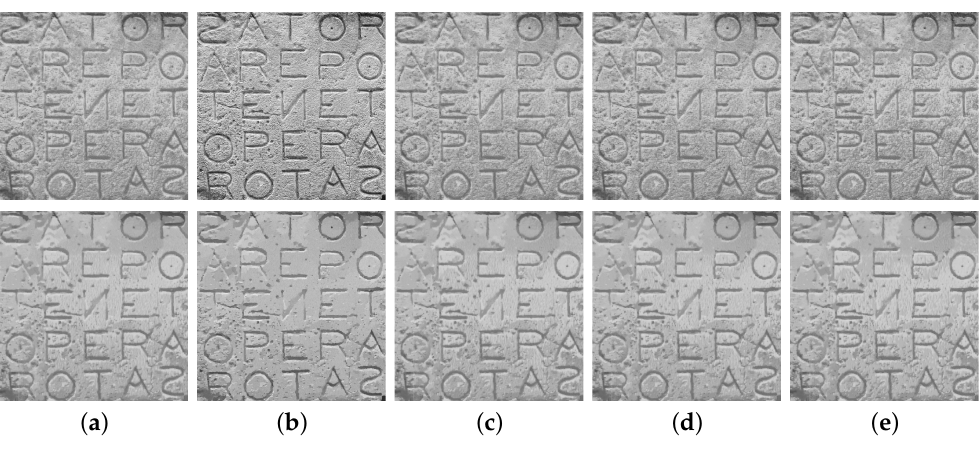
Figure 6. The comparison results between the existing method without and with our method. The top row is obtained without our method. The bottom row is obtained with our method. ( a ) TID